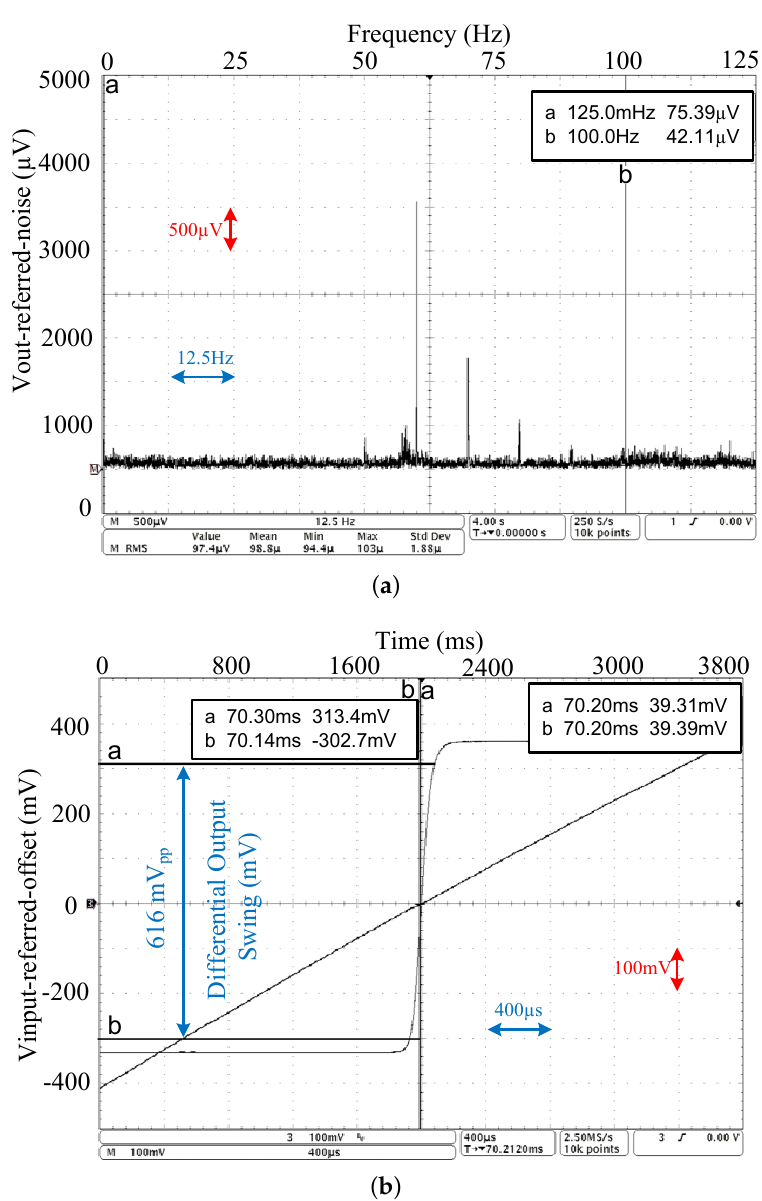
Figure 13. Measured open loop (R load = 10 M Ω and C load = 95 pF): ( a ) output-referred noise of the LPGA at 0.1 Hz, 50/60 Hz, and 100 Hz; and ( b ) input-referred offset voltage and maximum differential output swing of the LPGA for an input ramp of 1 V PP at 100